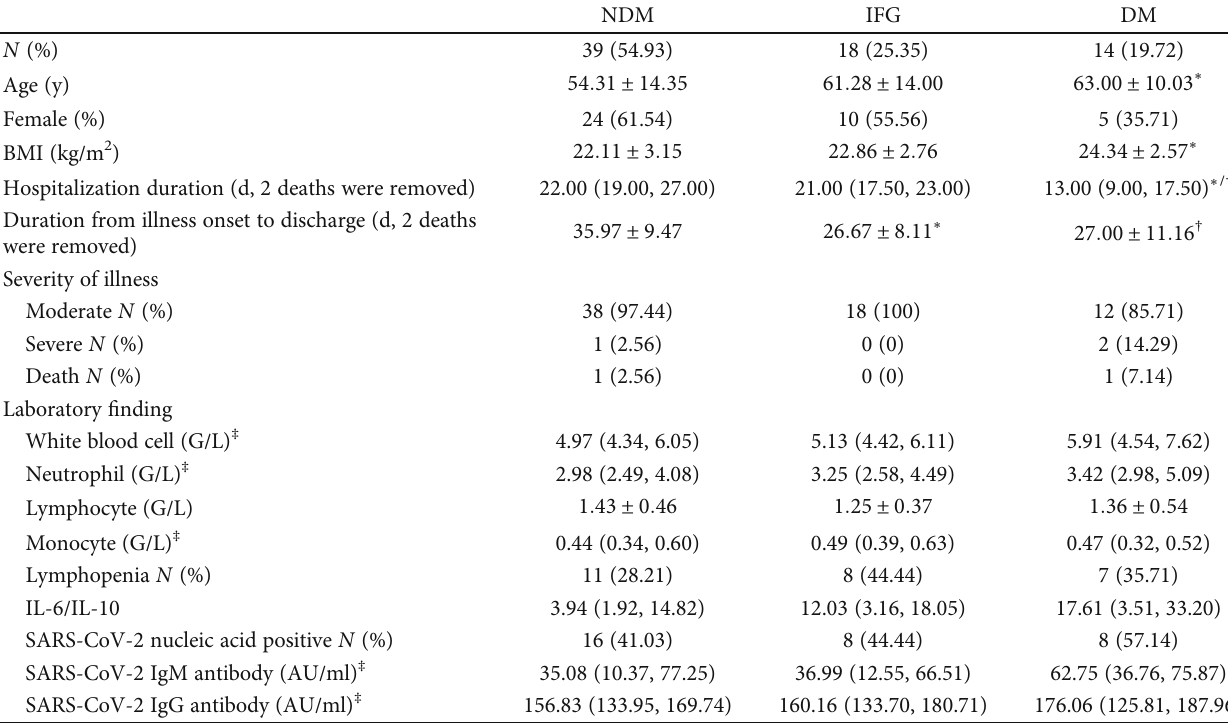
Table 1: Comparison of characteristics, immune response, and cytokines of patients in di ff erent groups.